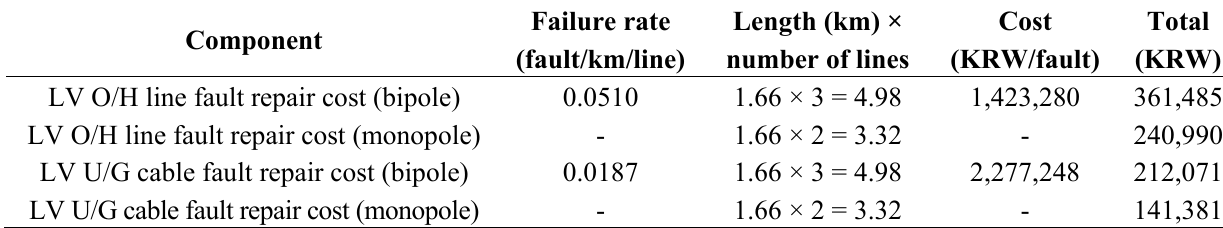
Table 9. Fault repair costs of